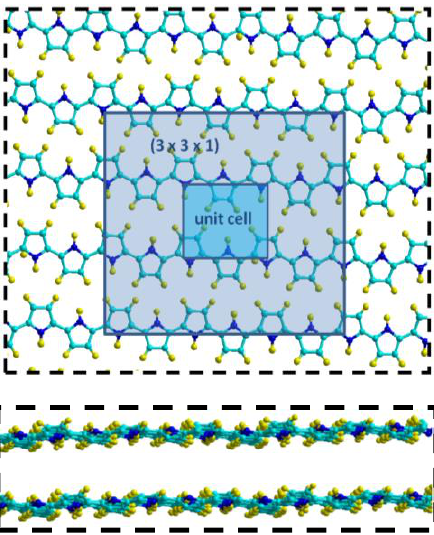
Figure 7. Model of polymer matrix considered for the calculations. The projection in plane shows the primitive lattice and the used super lattice (3 × 3 × 1) ( top ) and the side view show the inter-plane distance ( bottom ).